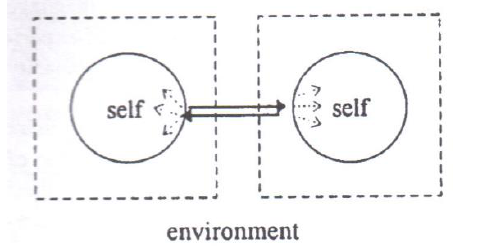
Figure 27: Intersubjective Stage (Evans 1998 p. 295)